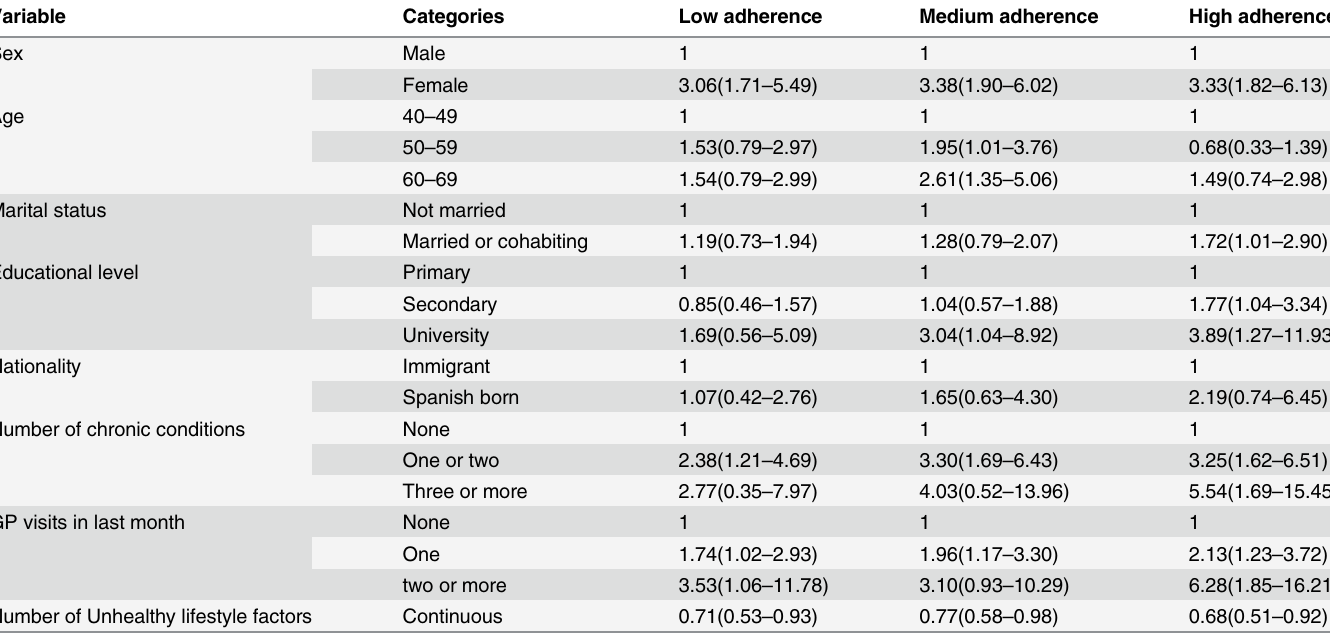
Table 4. Predictor of level of adherence to clinical preventive practice recommendations among diabetes